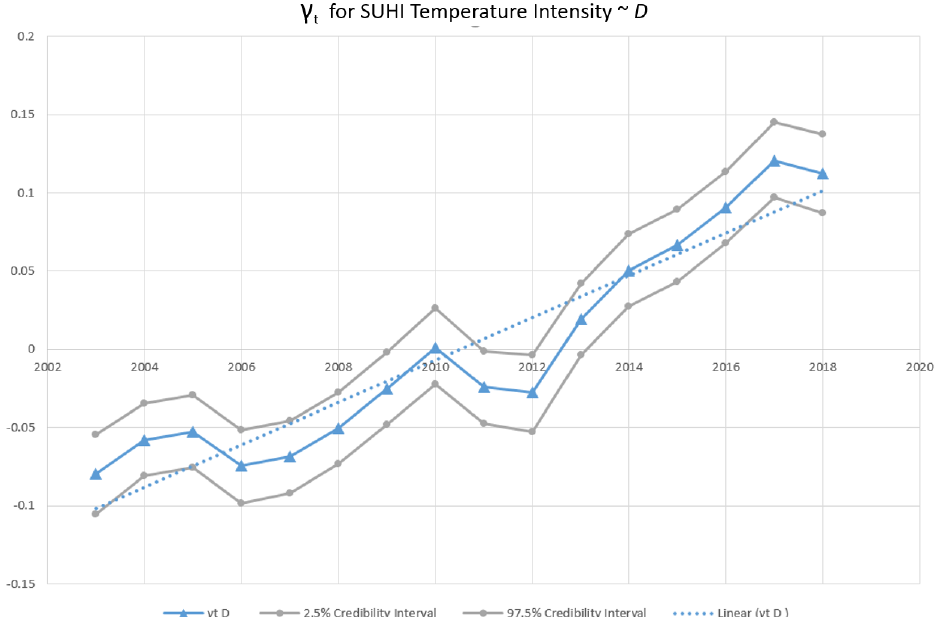
Figure 7. Temporal structure of Bayesian hierarchical spatial temporal model for city-level SUHI intensity and D Multi-Group Dissimilarity Index as an explanatory variable. γt is the temporally structured effect modeled as a random walk of order 1 (RW1). Line of best fit is determined by ordinary least squares univariate linear regression. n = 3056. Gray lines are 95% credibility values. Dased line is the line of best fit derived from ordinary least squares linear regression.